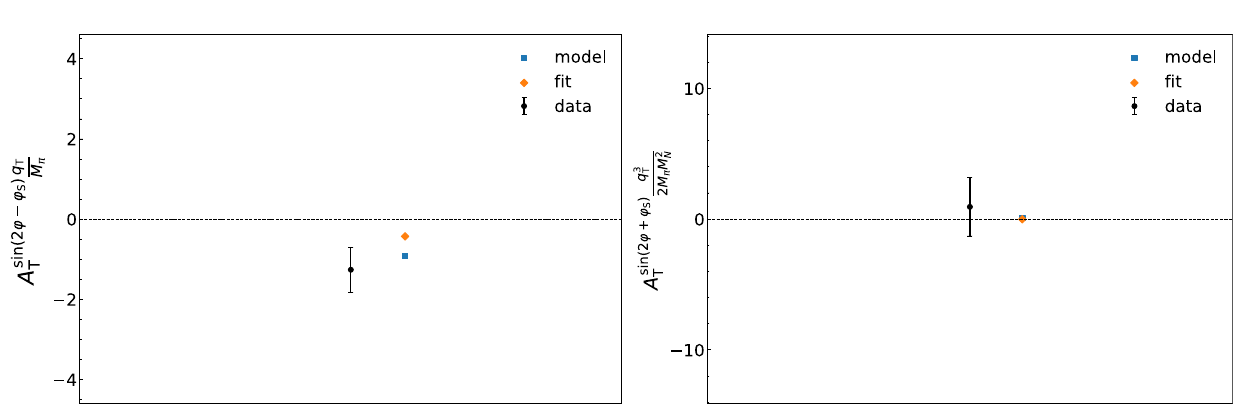
Fig. 5 q T -weighted Drell–Yan TSAs integrated over the entire kinematic range. The blue square represents the calculated results, and the red diamond represents the fit results. The data points include the estimated corrections for systematic errors. The error bars contain statistical